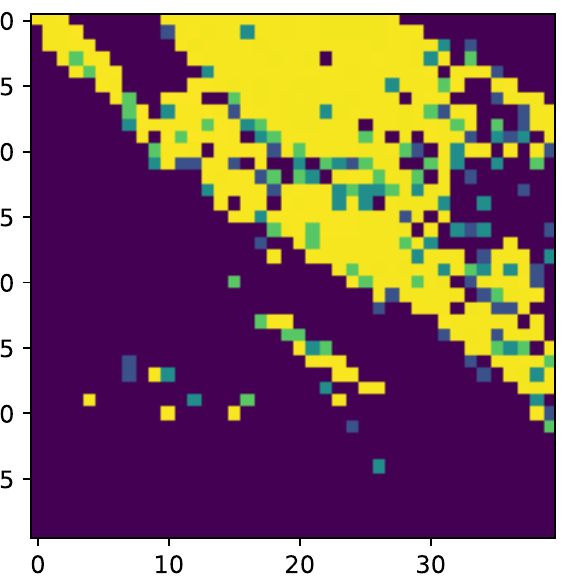
Figure 5. Example Downsampled MAIAC Satellite AOD Imagery (1 January 2019 within Los